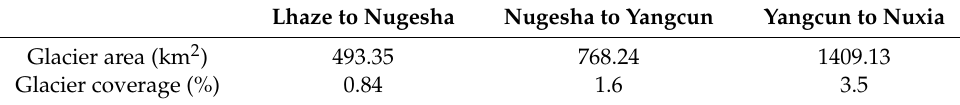
Table 2. Glacier characteristics of the study